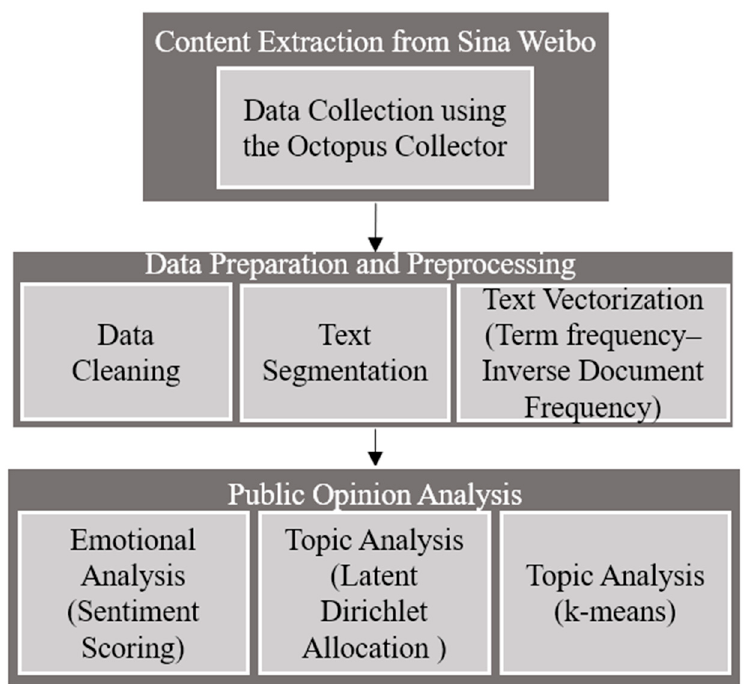
Figure 1. The research framework followed throughout this study.